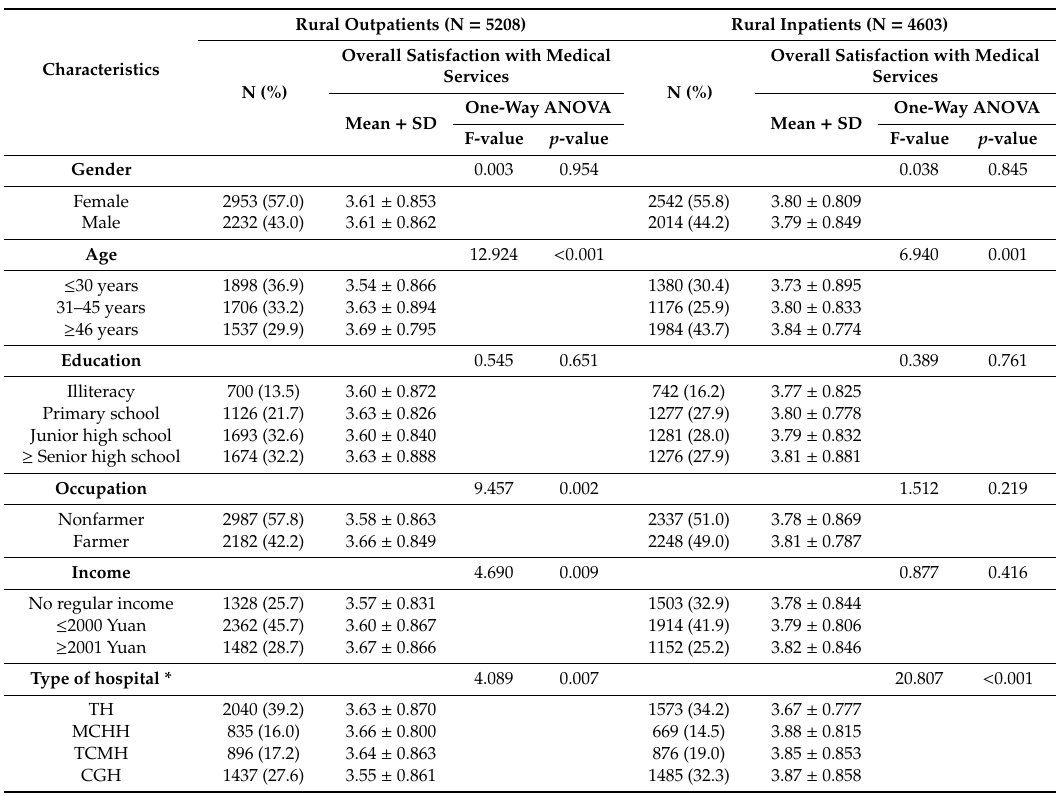
Table 1. Sociodemographic characteristics and the overall satisfaction of outpatients and inpatients with rural medical